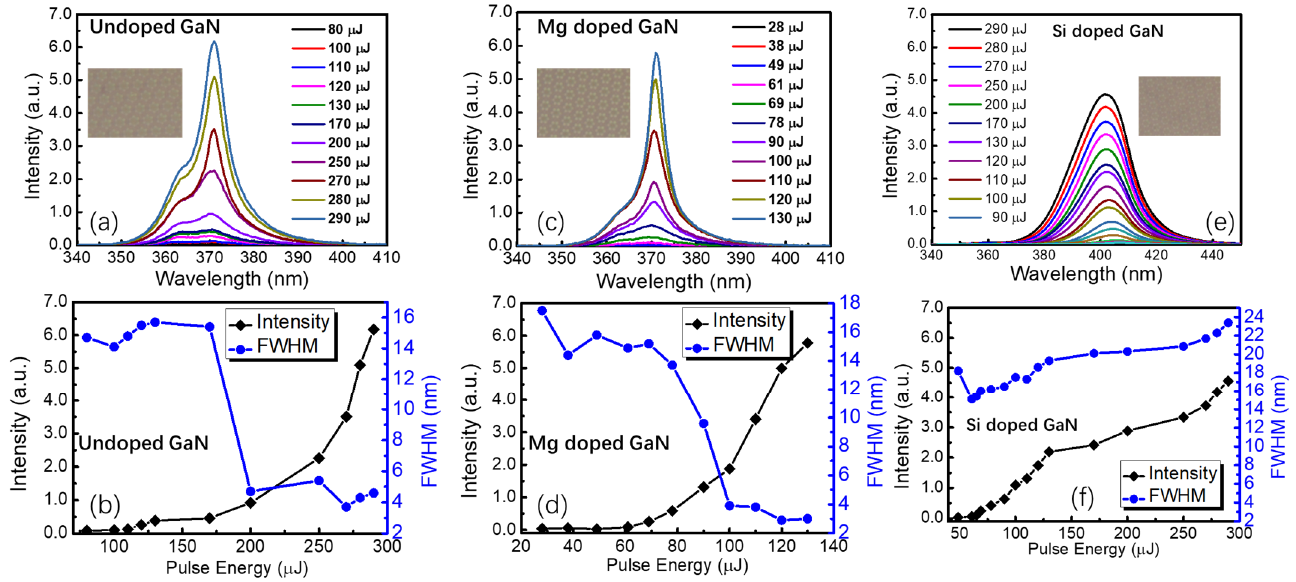
Figure 5. The fluorescence and lasing emission spectra of ( a ) undoped GaN, ( c ) Mg-doped GaN, and ( e ) Si-doped GaN thin films grown on the hexagonal lattice patterned periodic sapphire substrates (the insets are the molar pattern taken by a metallographic microscope); the lasing or fluorescence intensity and full width at half maximum (FHWM) varied along with the pumping pulse energy in ( b ) undoped GaN, ( d ) Mg-doped GaN, and ( f ) Si-doped GaN thin films grown on the hexagonal lattice patterned periodic sapphire substrates.